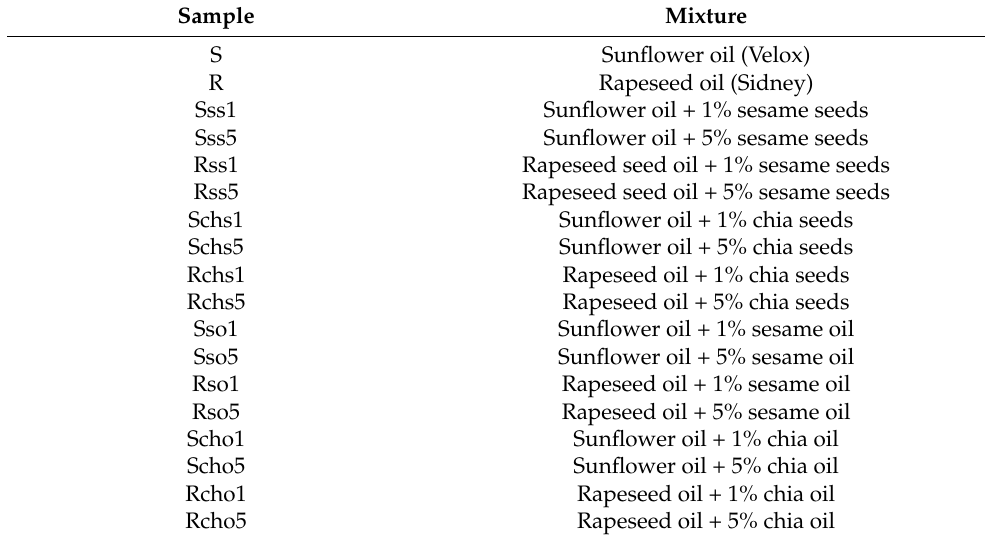
Table 1. Analyzed samples of fortified oil